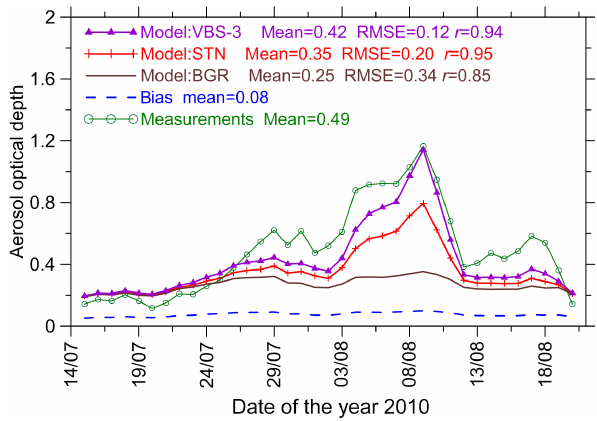
Figure 9. Time series of AOD at 550nm obtained from simulations made with different scenarios and derived from the MODIS mea- surements. The daily data are averaged over the whole study region (see Fig.